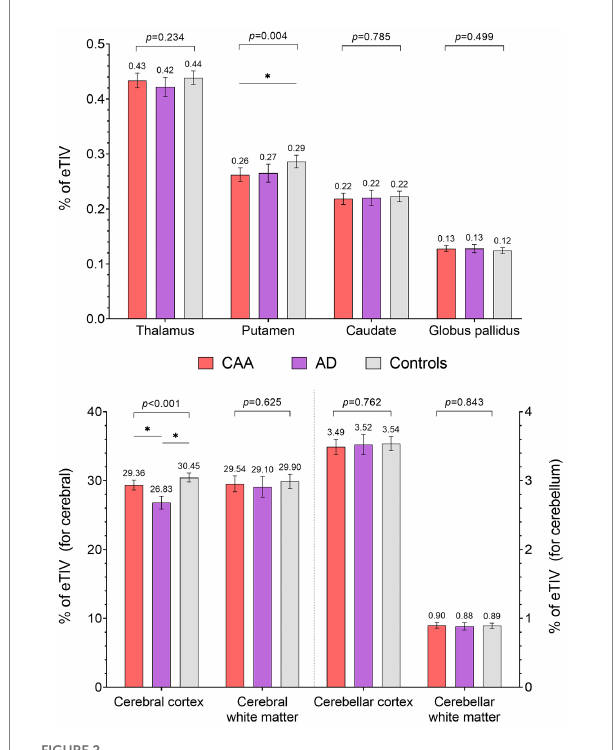
FIGURE 2 Comparisons of subcortical volumes (% of estimated total intracranial volume) between CAA, AD, and healthy controls (HC). * Post-hoc p <